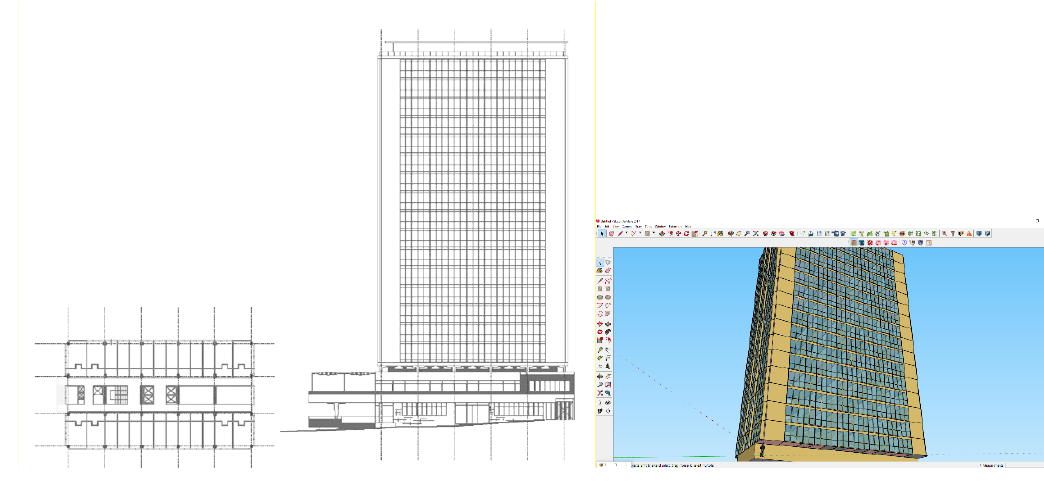
Fig. 2. 3-D model of the building